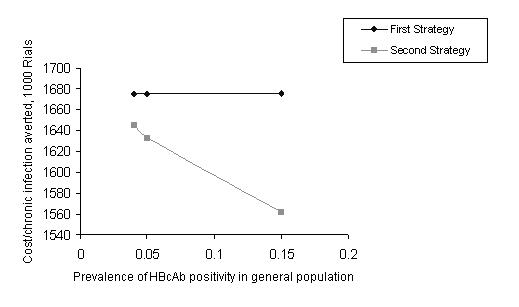
When the prevalence of HBcAb positivity in general population (P2) increased from the lowest to highest limit, the cost per chronic HBV infection prevented did not vary in strategy 1, but in strategy 2, it decreased from 1,645,720 Rials (198 $) to 1,561,530 Rials (188 $). Therefore, the higher rates of HBcAb positivity made the cost of strategy 2 become more remarkably lower than that of strategy 1.